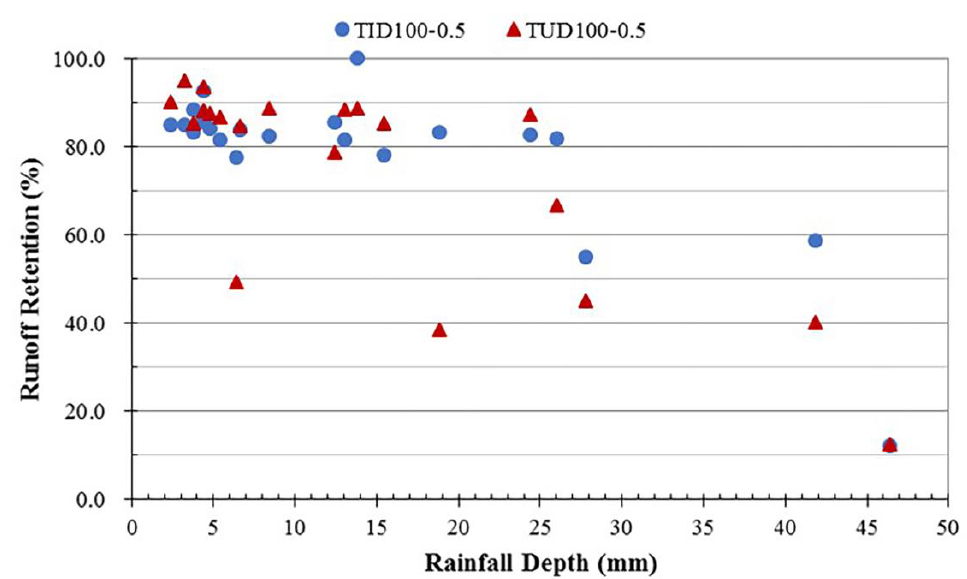
Figure 4. Rainfall retention rates R3 varying with different substrate hydraulic conductivity of EGR modules under the monitoring period.